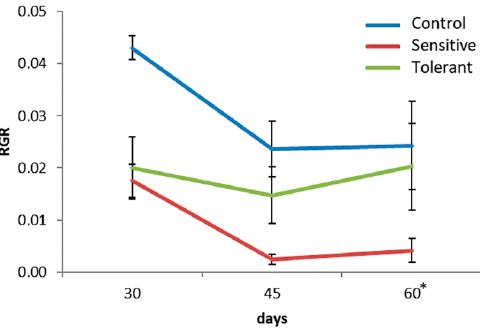
Figure 2. Relative growth rate (RGR) of the plants during the saline stress. Asterisk (*) indicates significant differences between tolerant and sensitive groups (Kruskal–Wallis test, p < 0.05). Agronomy 2020 , 10 , x FOR PEER REVIEW